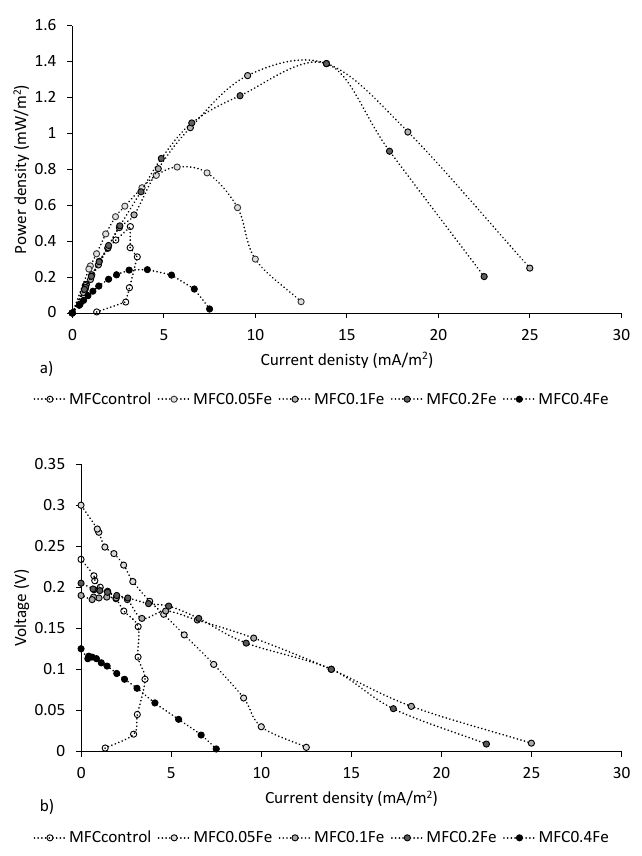
Figure 3. Power curves ( a ) and polarization curves ( b ) for all MFCs.